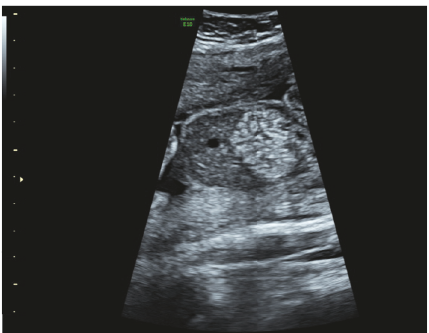
Figure 1: Echogenic bowel. Figure 2: Bilateral ventriculomegaly with oedema of the posterior ventricular wall and periventricular hyperechogenicity.